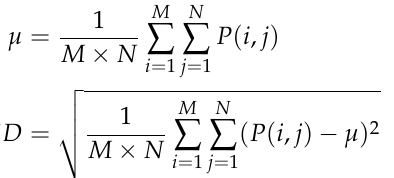
Figure 3. Examples of normalization of grayscale histogram. ( a ) A room image in Euroc dataset. ( b ) The grayscale histogram of the image. ( c ) Normalized grayscale histogram. Then, the normalized grayscale histogram is used to calculate the mean and standard deviation according to Equation (10) as a rough image feature